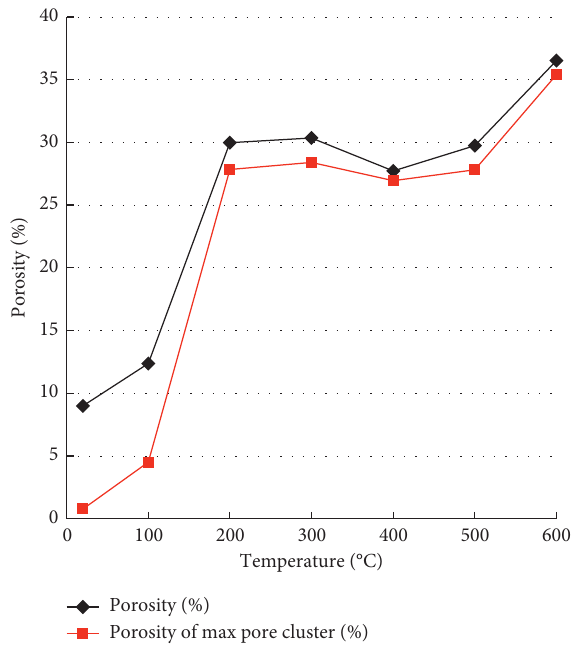
Figure 5: Porosity and the porosity of the maximum pore cluster at different temperatures.